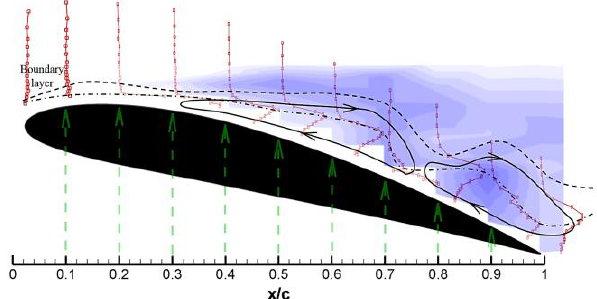
Fig. 5. U rms profile and turbulent kinetic energy contours over the NACA 4412 airfoil .